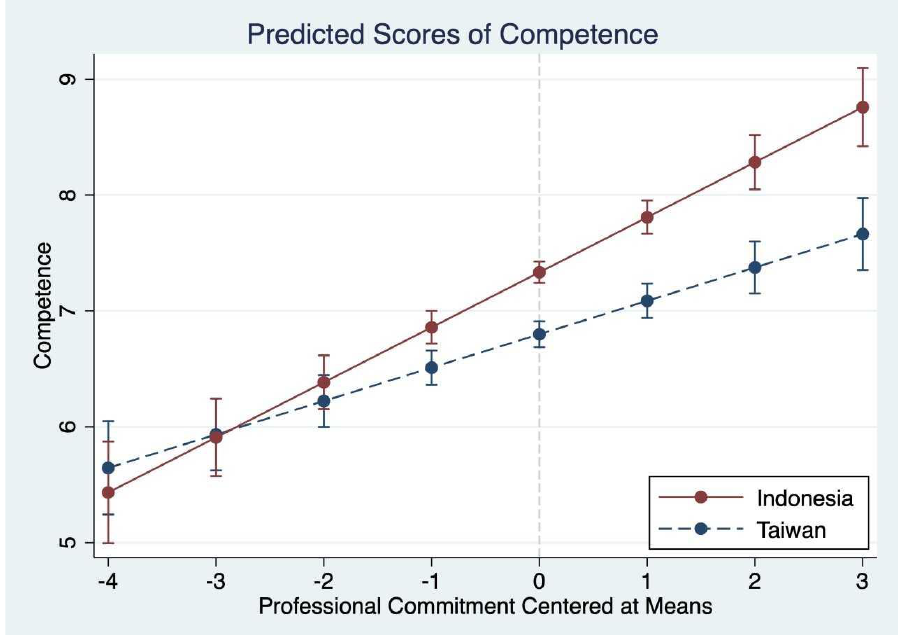
Figure 3. Predicted competence of Indonesia and Taiwan by commitment. Table 4. Results of regression models on